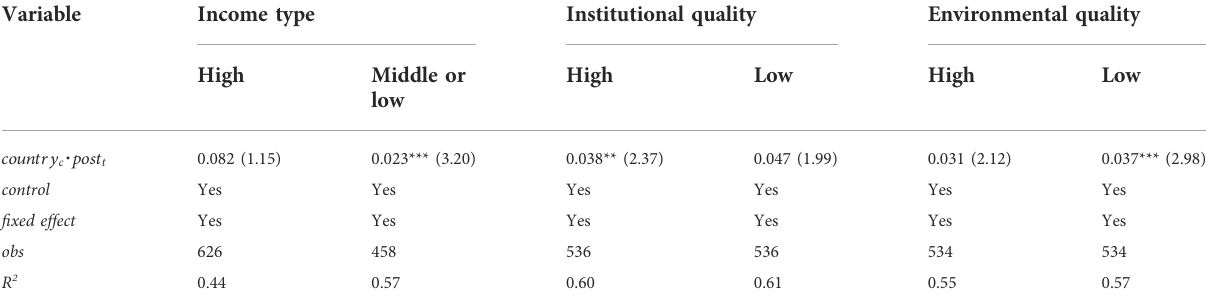
TABLE 5 Results of the heterogeneity